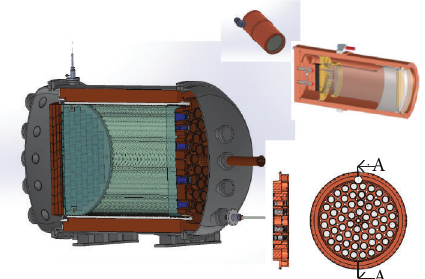
Figure 10: A drawing of the detector showing the energy plane inside the pressure vessel.